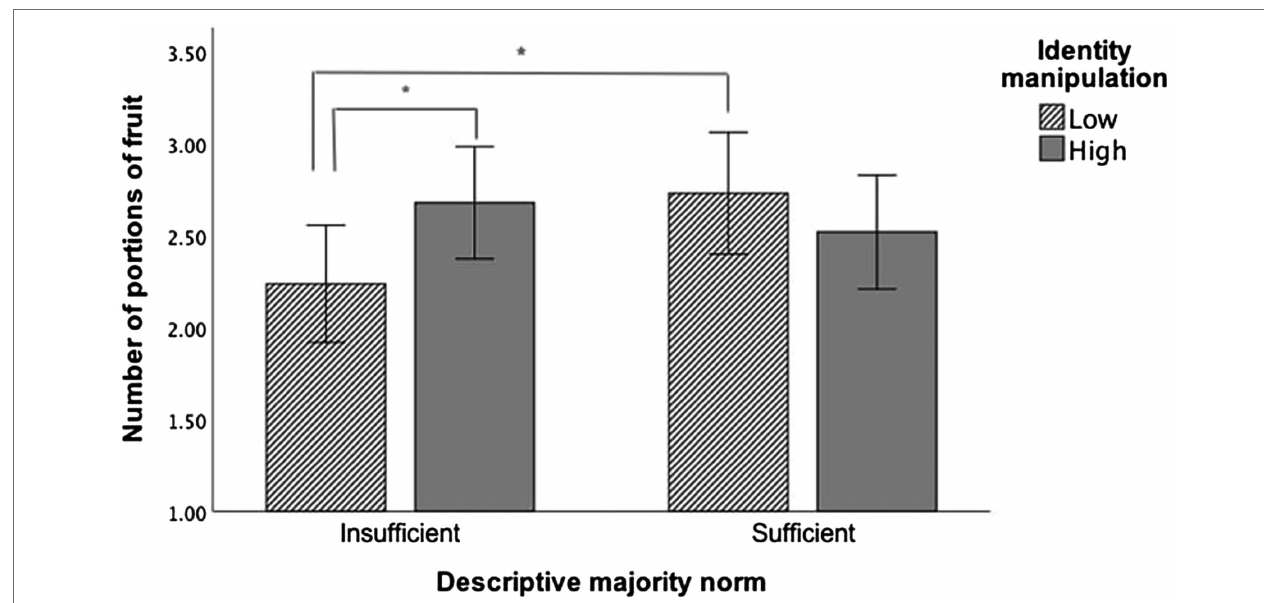
FIGURE 3 | Bar graph illustrating the cross-over interaction of the Norm (“sufficient”/“insufficient”) and Identification (“low”/“high”) manipulations on the number of portions of fruit participants intended to consume the following day. The means are adjusted for baseline intake, attitudes, perceived behavioral control, and identification as a “sufficient fruit and vegetable eater.” Error bars display 95% confidence intervals. Asterisk indicates significant difference at * p < 0.05. ( N =